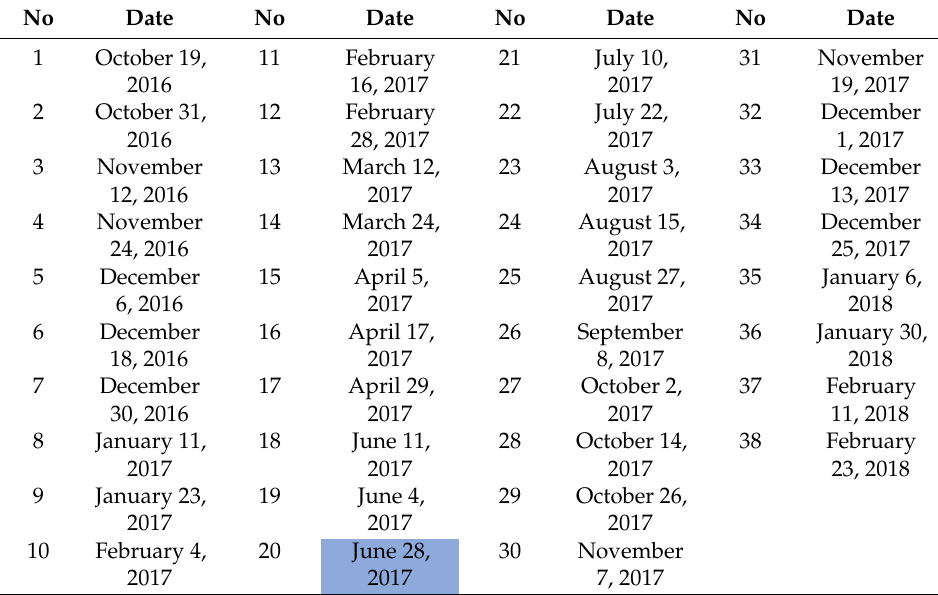
Figure 5. High-resolution false-color (NIR, green, blue) Sentinel-2 image (June 27, 2017) for southern Greece/Turkey containing DL (a), TFV (b) and TOW (c).